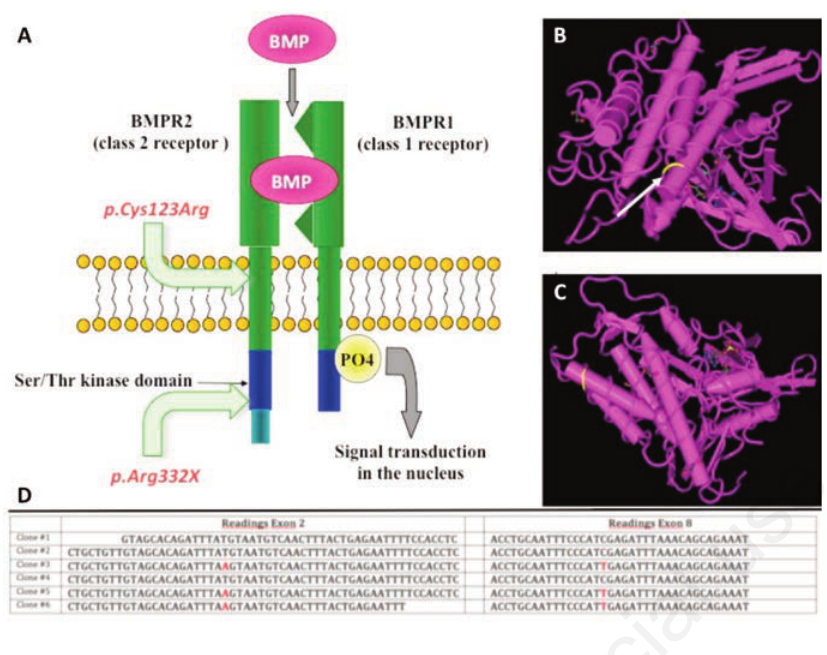
Figure 4. Molecular testing and protein modeling. A) BMPR2 receptor structure high- lighting the positions of the two found mutations: the first within the transmembrane domain (p.Cys123Arg) and the second within the Ser/Thr-kinase domain (p.Arg332X). B) and C) PyMol software protein modeling highlighting in yellow the p.Cys123Arg mutation and the p.Arg332X mutation. D) Aligned clones resulting from next generation sequencing and analysis: clones always contain both mutations indicating that both mutations are on the same allele and do not segregate (cis